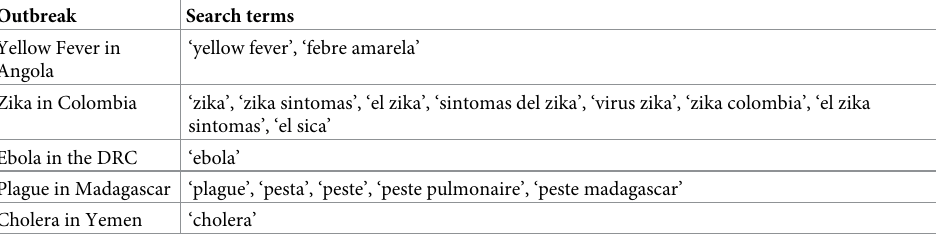
Table 4. Search terms by